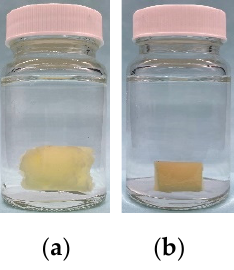
Figure 14. Gel aged in a hard brine with different salinities: ( a ) Brine with salinity of 10,000 mg/L; ( b ) Brine with salinity of 100,000 mg/L.